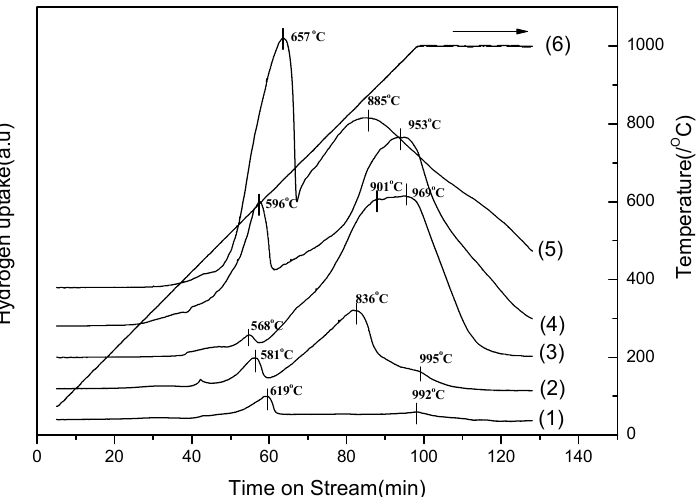
Figure 6. XPS of Fe 2p 3/2 in the reduced catalysts of ( a ) MNC 0.5 F 0.3 and ( b ) MNC 0.0 F 0.8 , and spent catalysts of ( c ) MNC 0.5 F 0.3 and ( d ) MNC 0.0 F 0.8 .